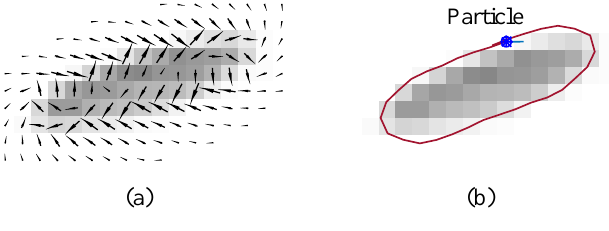
Figure 2. ( a ) a combined vector field, α (cid:126) e + β (cid:126) n , α = 0.5, β = 0.5, and ( b ) a boundary extraction